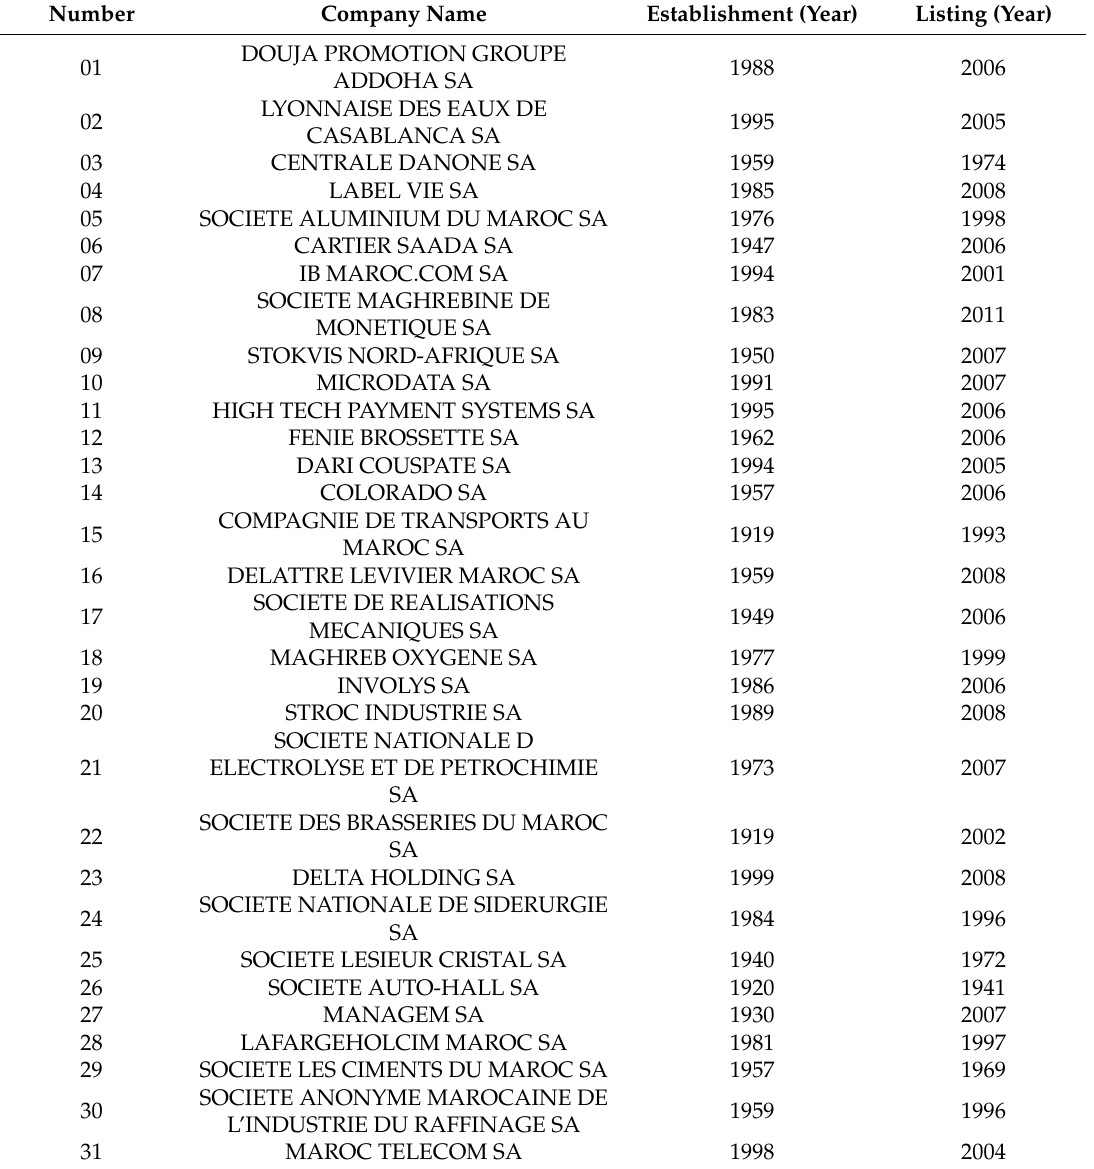
Table A2. List of selected non-financial companies listed in